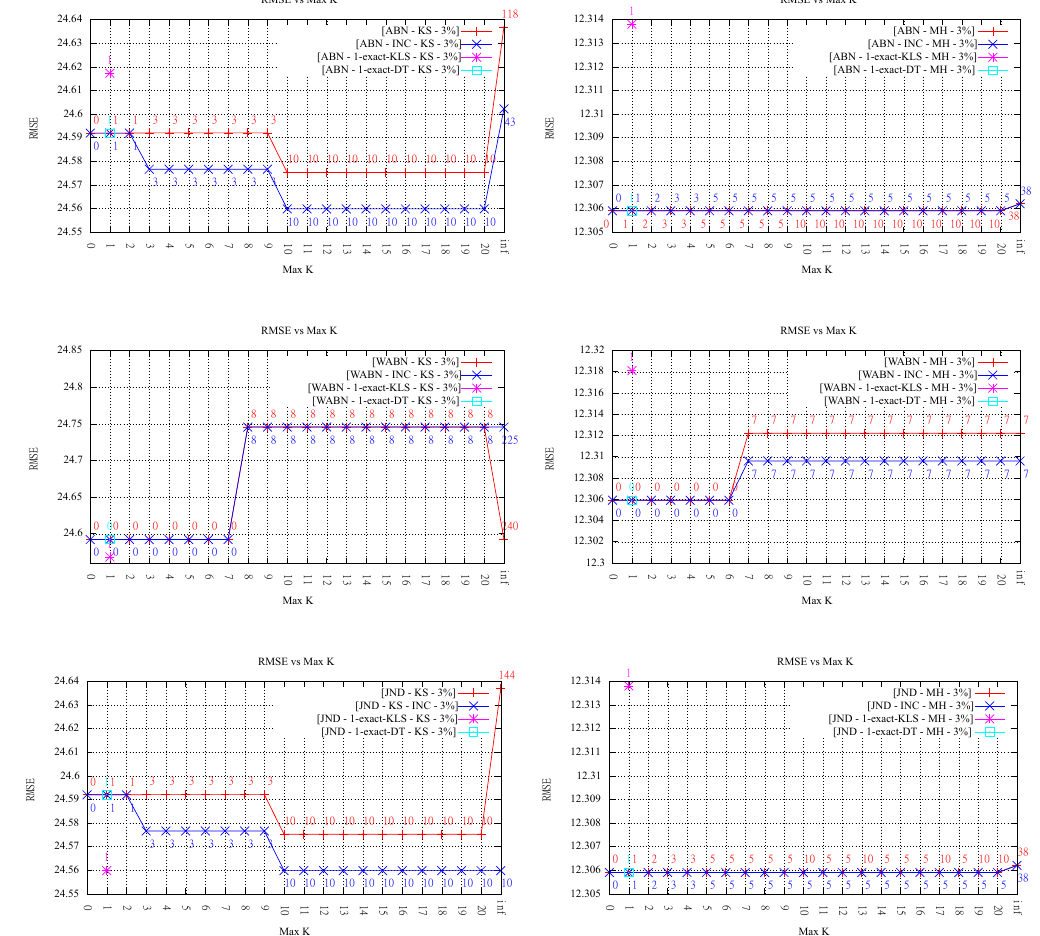
Figure 6. RMSE evaluation for Kinzel Springs ( left ) and Moorehead SE ( right ) over 3% sample point set as the maximum order k increases. In each column, from top to bottom: ABN, WABN and JND. Numbers indicate the final